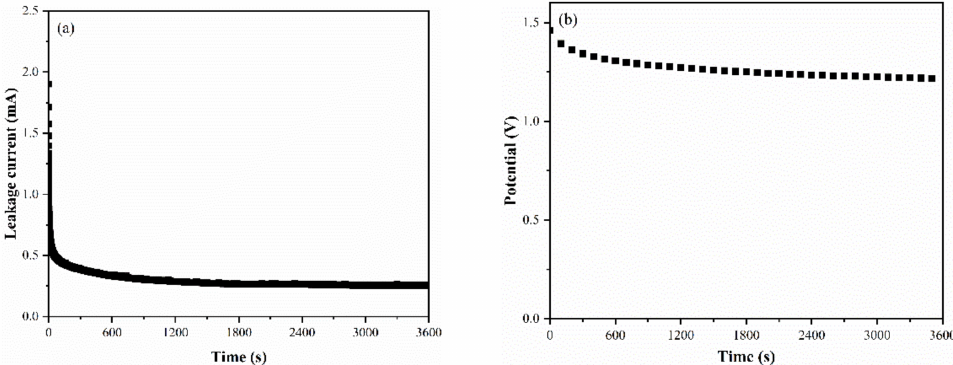
Figure 11. ( a ) Leakage current and ( b ) self-discharge of supercapacitor